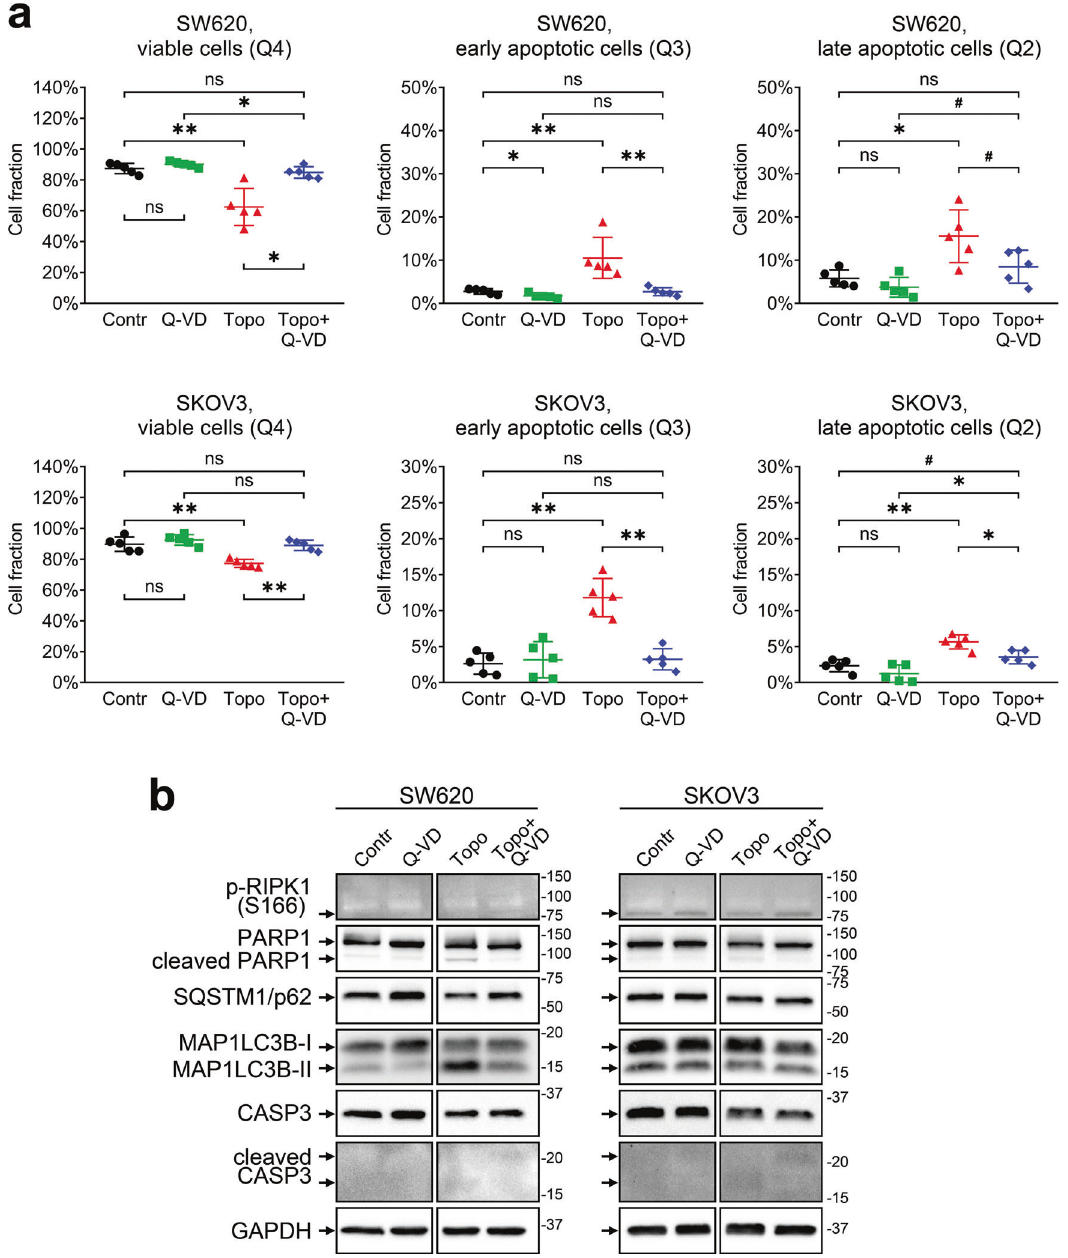
Fig. 4 Cytotoxic effects of topotecan treatment in SW620 and SKOV3 cell lines (Annexin V/PI and Western blot assays). The cells were treated with topotecan (20 nM for SW620, 70 nM for SKOV3) in the presence or absence of 25 μ M of Q-VD. a Fractions of viable and apoptotic cells estimated with the Annexin V/PI assay. The lines and whiskers indicate mean ± standard deviation ( N = 5). b Western blot analysis of protein levels. The samples are indicated above; the proteins of interest are indicated on the left; molecular weight markers are indicated on the right. “ Contr ” – control samples; “ Topo ” – proliferation arrest only (Fig. 5). This fact is in complete agreement a decrease in the SQSTM1/p62 level. However, there were no with our earlier observation that even the highest concentration of changes in RIPK1 phosphorylation. There were no consistent cisplatin could not reduce the number of viable SKOV3 cells below differences in autophagic or necroptotic proteins in SKOV3 40% of the control level due to the lack of cell death (Fig. 1). In cells upon topotecan treatment (Fig. 4b). addition, cisplatin treatment of SKOV3 cells was unable to induce Because SKOV3 cells were much more resistant to the cytotoxic prominent autophagy- and necroptosis-associated protein changes action of topotecan, we decided to check their sensitivity to previously observed in SW620 cells (Figs. 2d and 5d). Therefore, we cisplatin-based cell death induction using our established set of conclude that SKOV3 cells, while displaying susceptibility to the experiments. As expected, SKOV3 cells were almost completely cytostatic action of various drugs, may exhibit universal resistance to insensitive to the cytotoxic effects of cisplatin, so the reduction in the cytotoxic stimuli. the number of viable cells after cisplatin treatment was due to